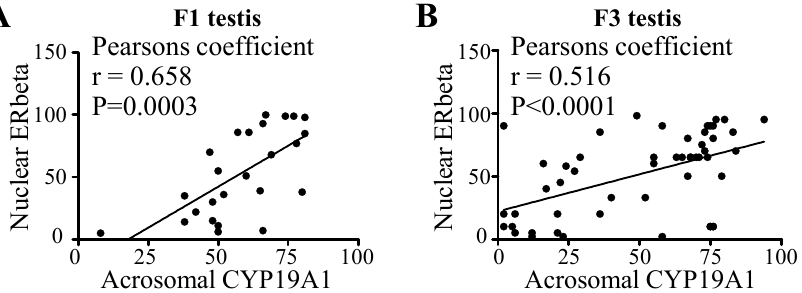
Figure 6. Correlation analysis of nuclear ERbeta and acrosomal CYP19A1 localization using pooled samples of all groups in the ( A ) F1 and ( B ) F3 generation testes. Each symbol represents a pup from an independent litter.